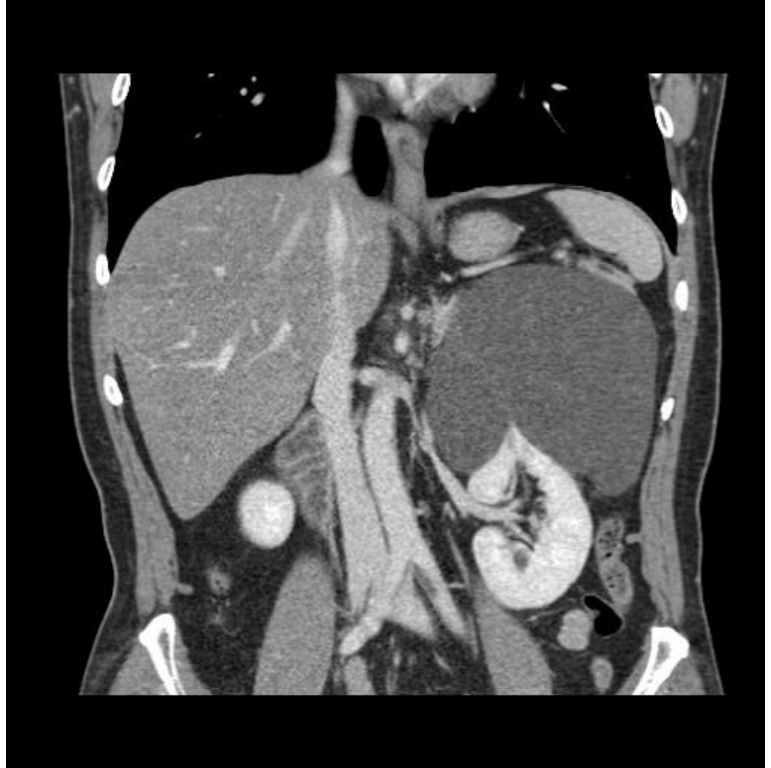
Figure 1. Preoperative CT scan revealed a 14 cm-sized renal cyst with thin septa at the upper pole of left kidney.